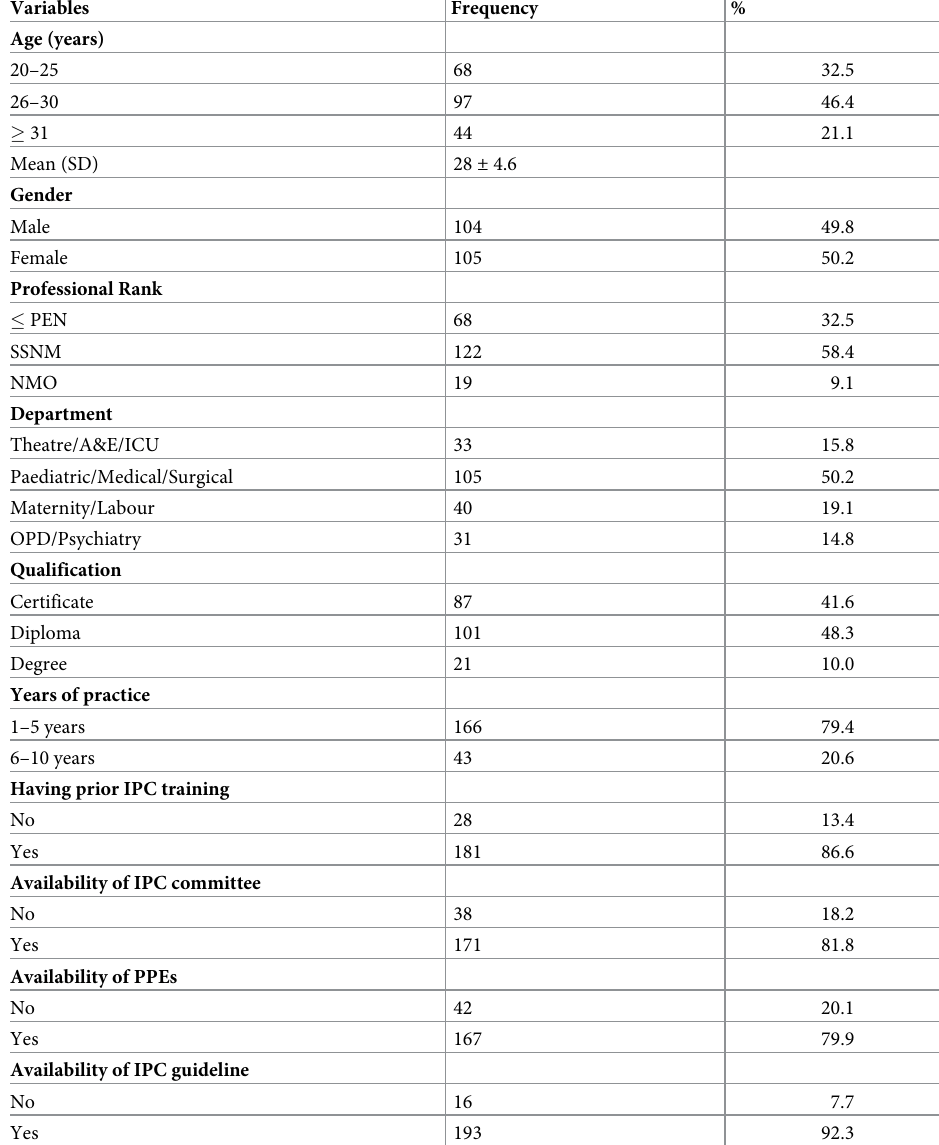
Table 2. Socio-demographic characteristics of respondents (n =